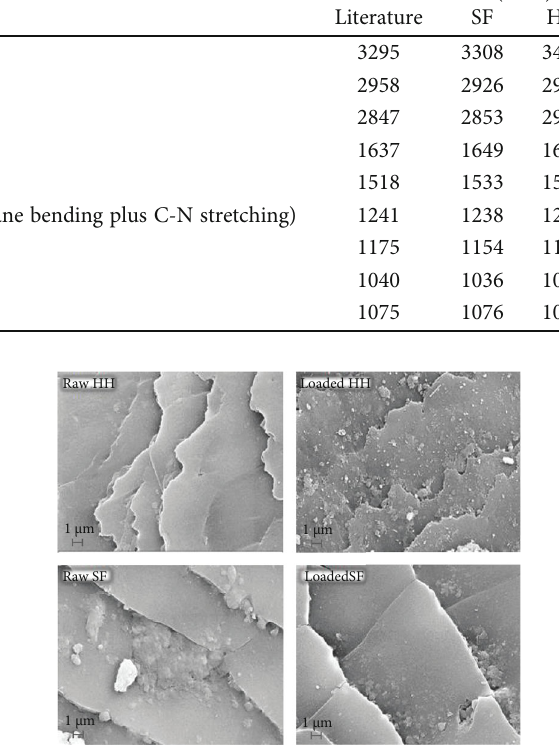
Figure 2: SEM images ( × 5000) of HH and SF used in the adsorption of heavy metal